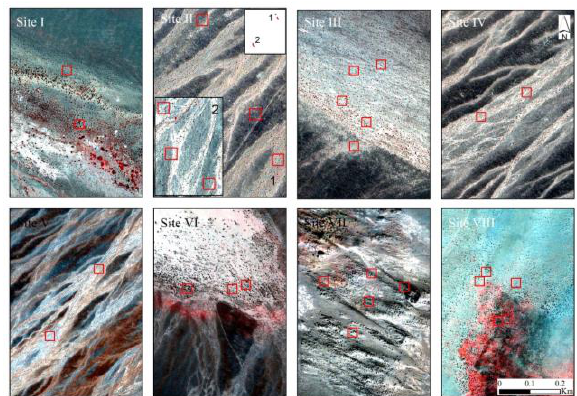
Figure 2. The false colour image of the satellite image, in which the red, green and blue colours are respectively displayed by NIR, Green and Blue bands of Pleiades-1 (50 cm). The images were acquired between July and September 2017. Shrub covers are shown from red to dark red colours. The red curve in the figure is the borderline of the plot area.